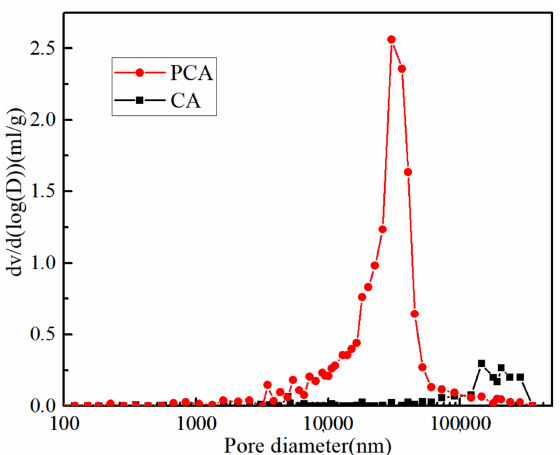
Figure 5. Pore diameter distributions of two kinds of ca-alginate